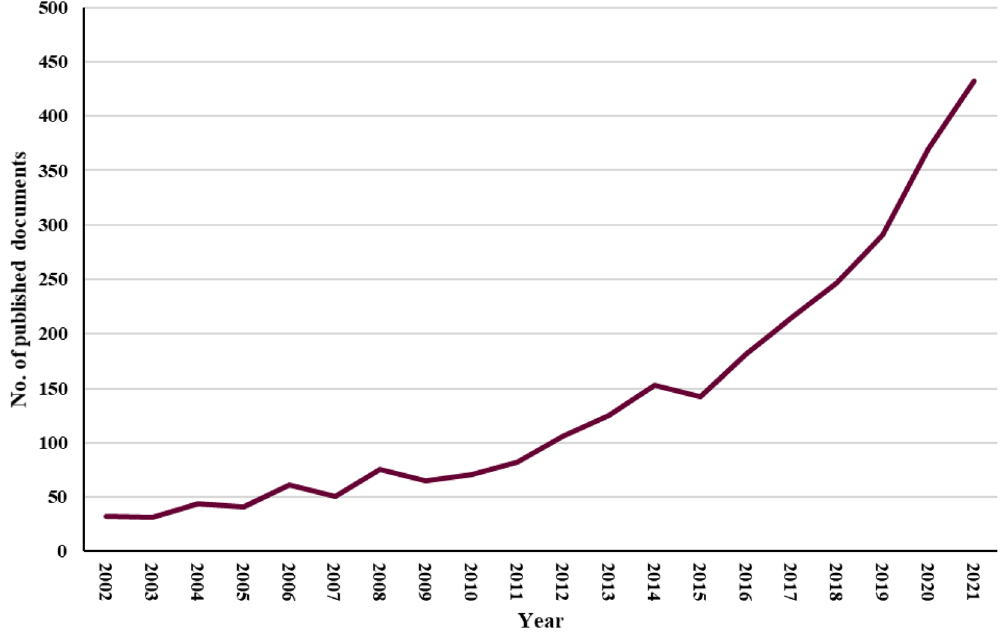
Figure 1. Trends in publications for research on the microbiota and antibiotics between 2002 and 2021.